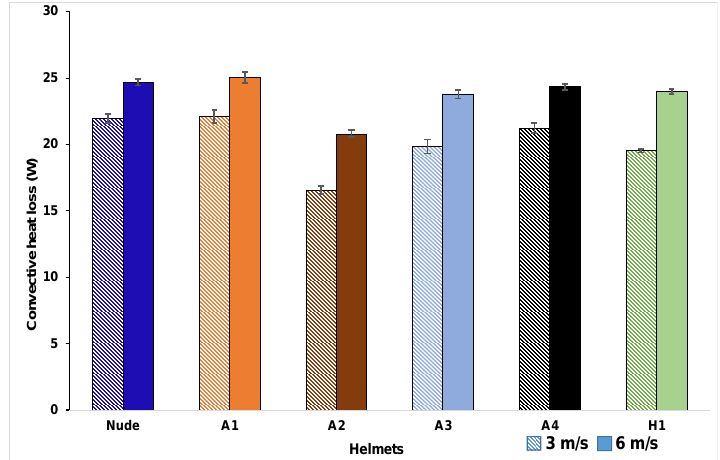
Figure 5. Convective heat loss of helmet ensembles at tested velocities (confidence intervals obtained for a 95% confidence level and a sample size of three).